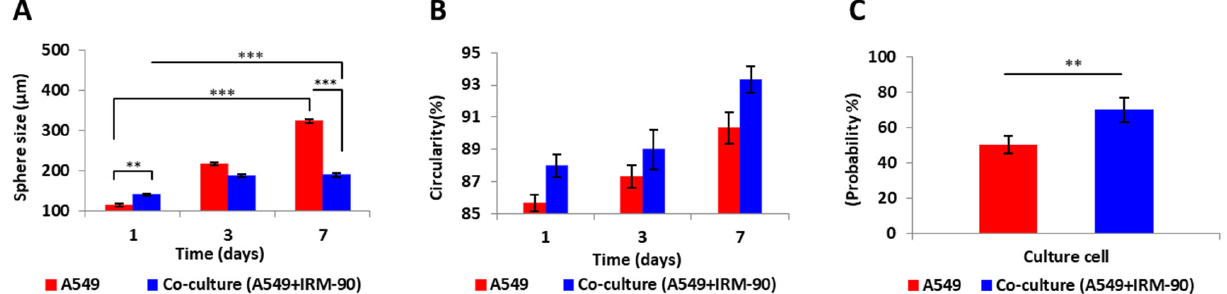
Figure 7. Comparing mono-type MCTSs produced from tumor cells (A549) with hetero-type MCTSs of tumor: stromal (A549:IRM-90, ratio 1:1) cells. ( A ) Changes in spheroid size over 7 days of culture. In both conditions (mono-type and hetero-type MCTSs), size of the spheroids on day 7 was significantly increased when compared to day 1 (D1 vs. D7 *** p < 0.0001). Spheroid size on day 1 was significantly different when comparing mono-type with hetero-type MCTSs (** p < 0.001). The size of mono-type MCTSs compared with hetero-type MCTSs on day 7 was significantly different (*** p < 0.0001). The size of spheroids in the co-culture model did not change significantly after day 3 of culture, while in mono-culture, spheroid size increased significantly on day 7 when compared to day 3 (D3 vs. D7 *** p < 0.0001). ( B ) Circularity of the spheroids was not significantly different in mono-type MCTSs when compared to the co-culture model. ( C ) Probability of spheroid formation on-chip is greater in the co-culture model when compared with the monotype MCTS model (** p < 0.001). The total number of cells is 1 × 10 6 cells/mL for all three ratios. p < 0.05 is considered statistically significant. High-resolution images of 10 spheroids in each independent experiment have been considered for calculations per each condition. All assays were performed as triplicates per trial in three independent experiments. (Error bars represent ± SE, n = 3.).